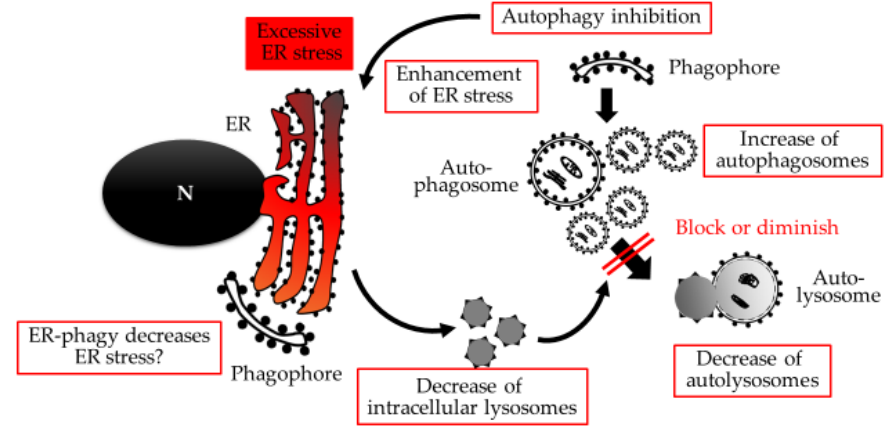
Figure 2. Excessive ER stress-mediated autophagy inhibition. Excessive ER stress, which is enhanced with autophagy inhibition, decreases the number of lysosomes in trophoblasts. The decrease of lysosomes results in the blocking or diminishing of autophagy flux. Meanwhile, ER-phagy might be involved in decreasing ER stress. N: